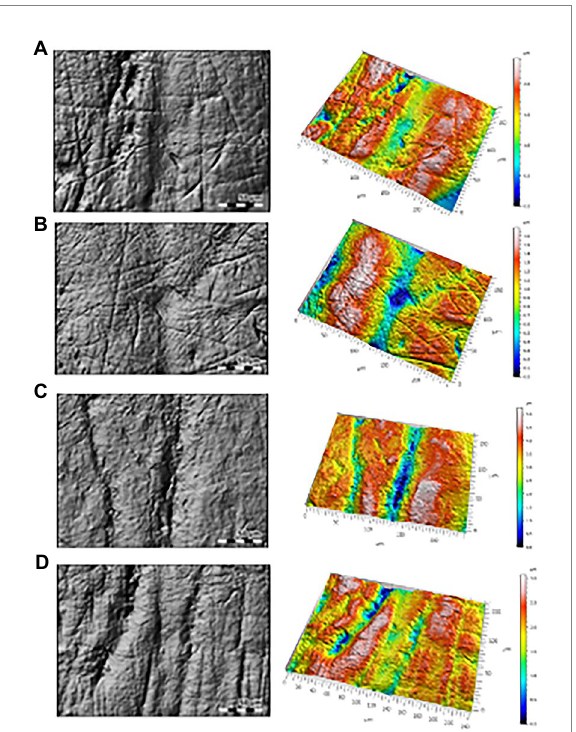
FIGURE 1 Photosimulation (left) and 3D view (right) of (A) Neandertal Krapina 13, a deciduous left lower lateral incisor; (B) Early modern human from Saint Germain 1970-7-4, a deciduous incisor; (C) Recent modern human from Amarna Egyptian SK304, a left deciduous central incisor; (D) Recent modern human from Point Hope 108, an upper left deciduous central